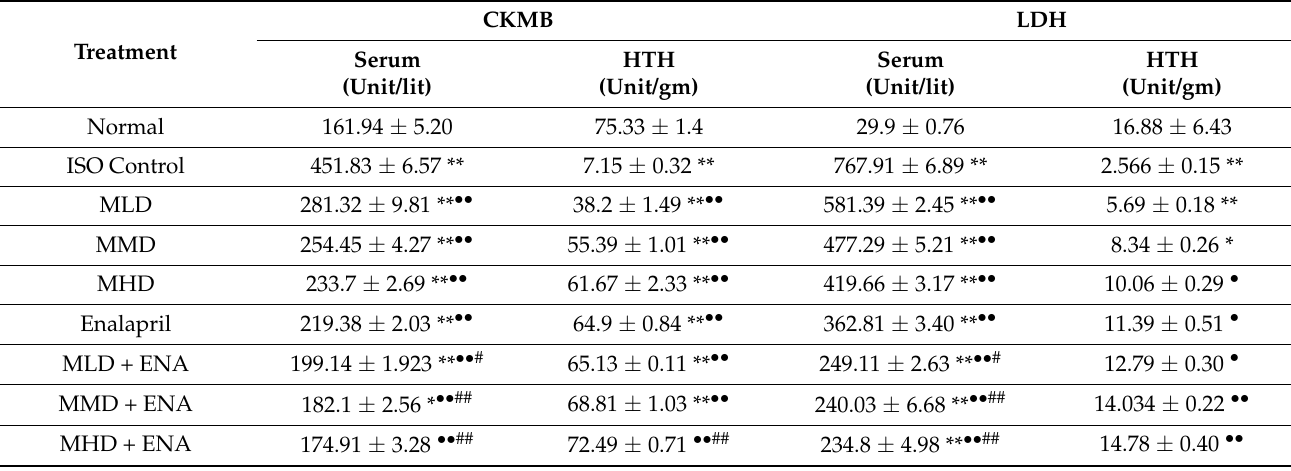
Table 3. Effects on the LDH and CKMB levels in the serum and heart tissue homogenate against isoprenaline-induced chronic myocardial infarction.